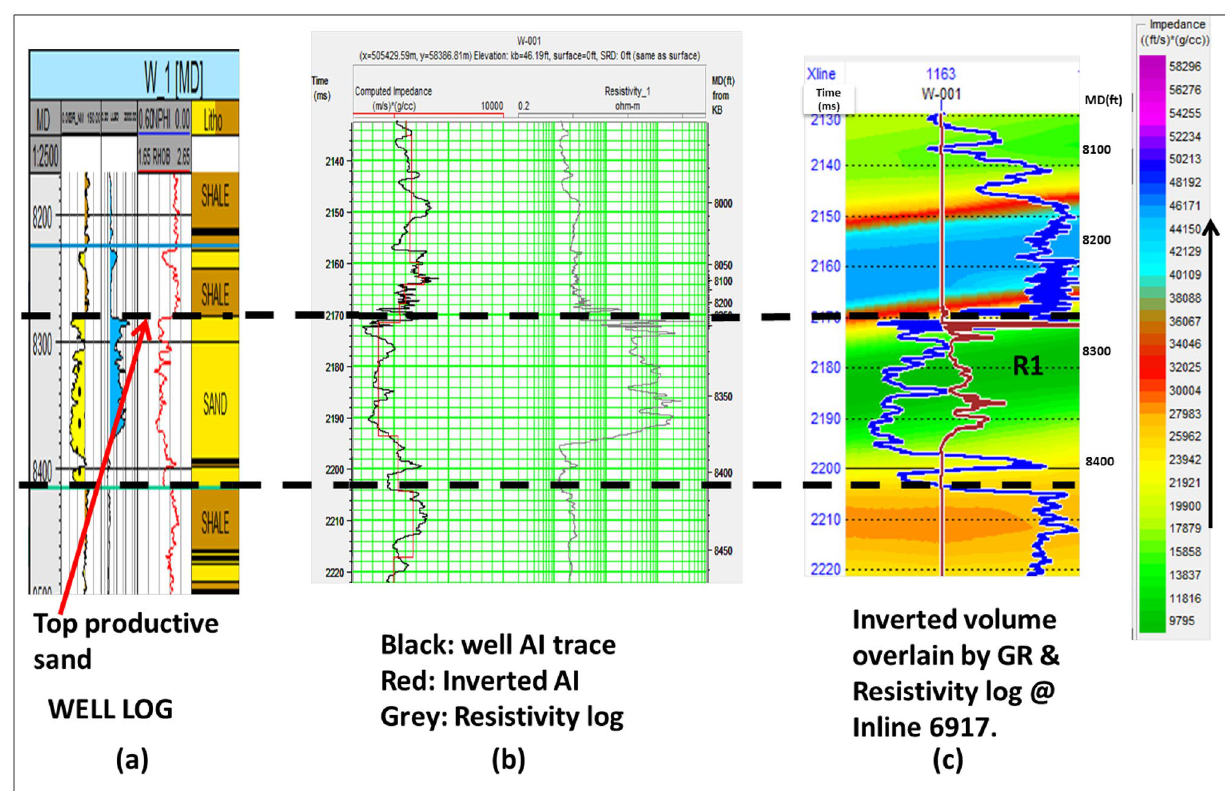
Fig. 6 Link between seismically derived acoustic impedance attribute and well logs at the productive zone in well